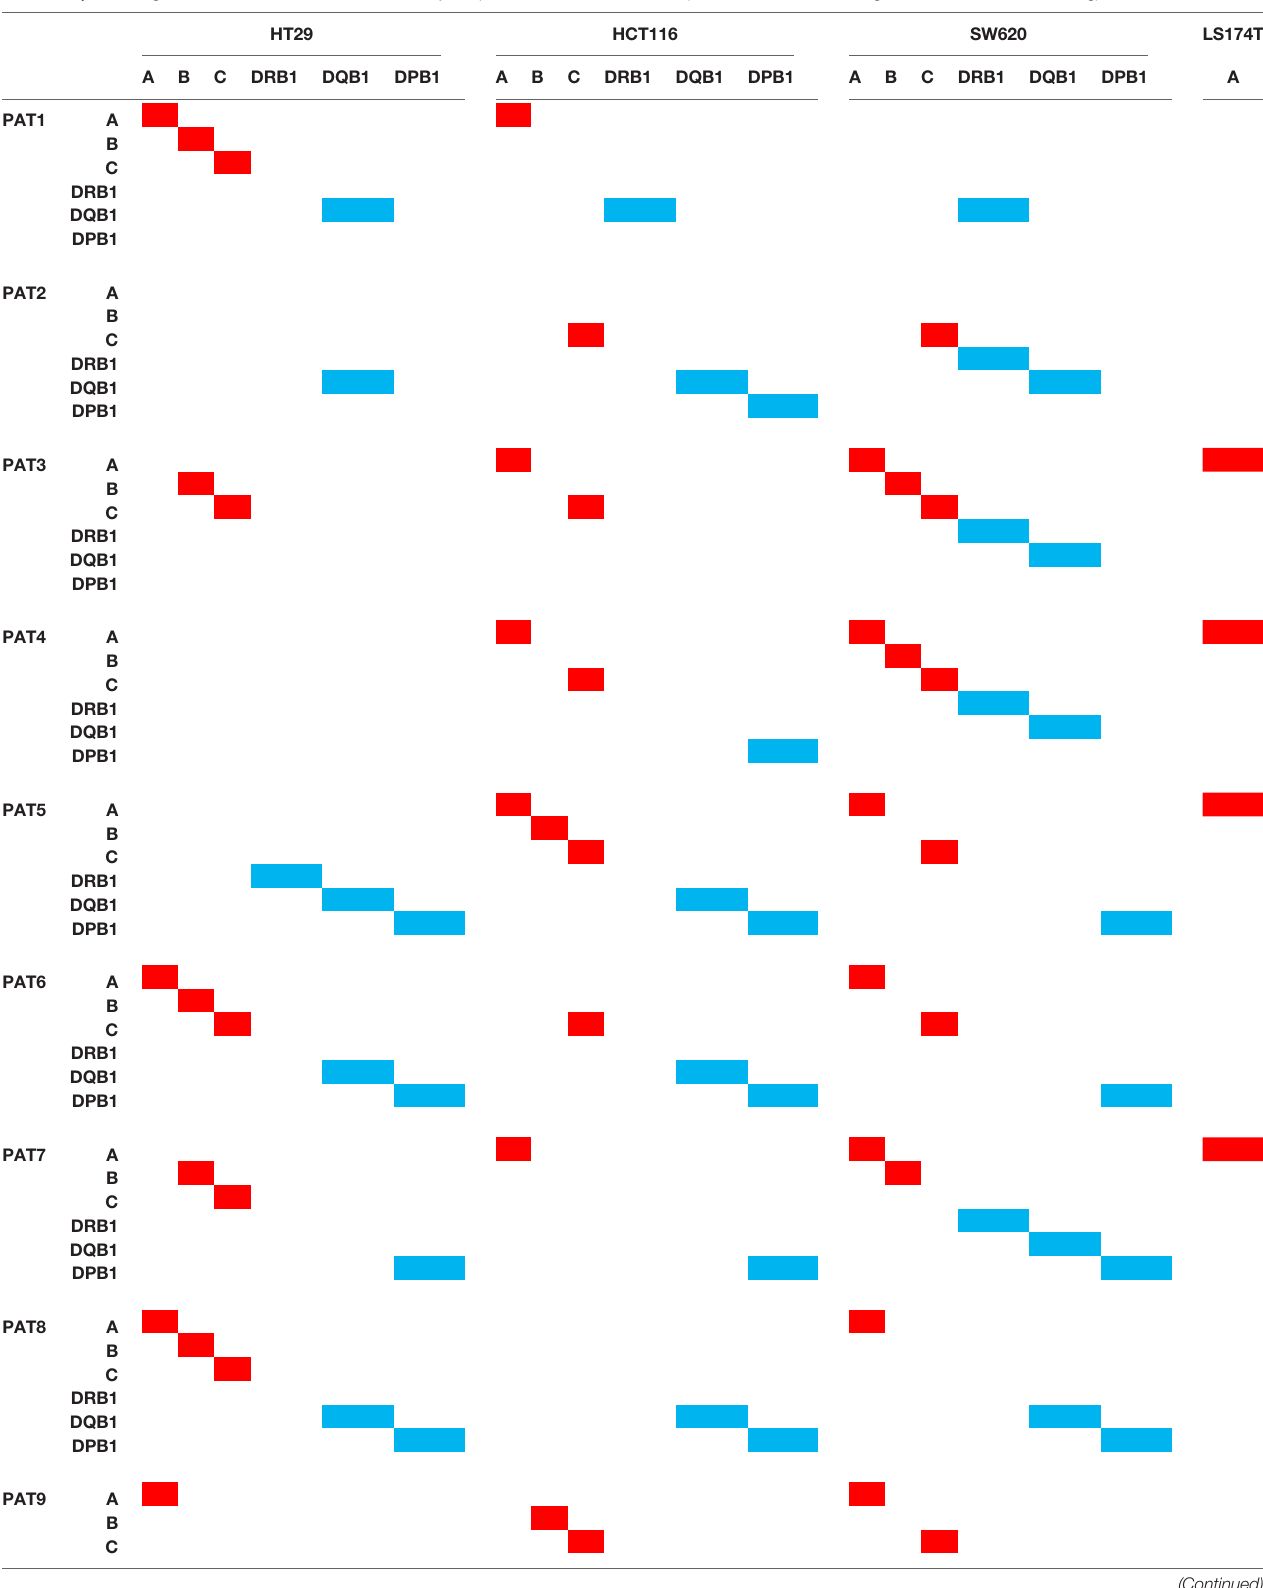
TABLE 6 | Matching of HLA classes I and II between analyzed patients and CRC cell lines (red: HLA class I matching; blue: HLA class II